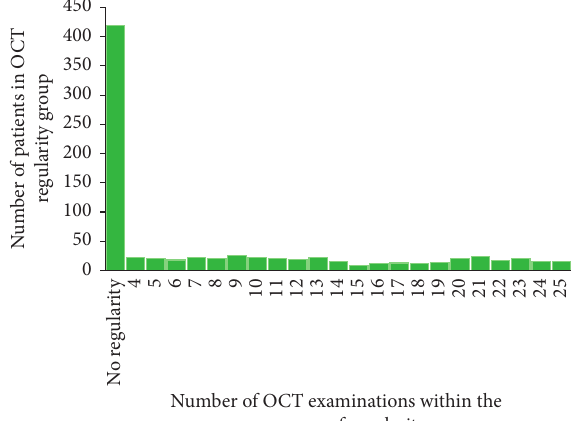
Figure 8: Number of OCT examinations within the sequence of regularity. Note: for OCTexaminations to be considered regular in the initial loading phase during the first 3 months, subsequent OCT examinations had to occur within 21 and 60 days and the difference in any of the intervals could not be more than 30 days. For OCT examinations to be considered regular in the later maintenance phase, subsequent OCTexaminations had to occur within 21 and 90 days and the difference in any of the intervals could not be more than 45 days. A sequence of regularity had to contain at least 4 OCT examinations. OCT: optical coherence